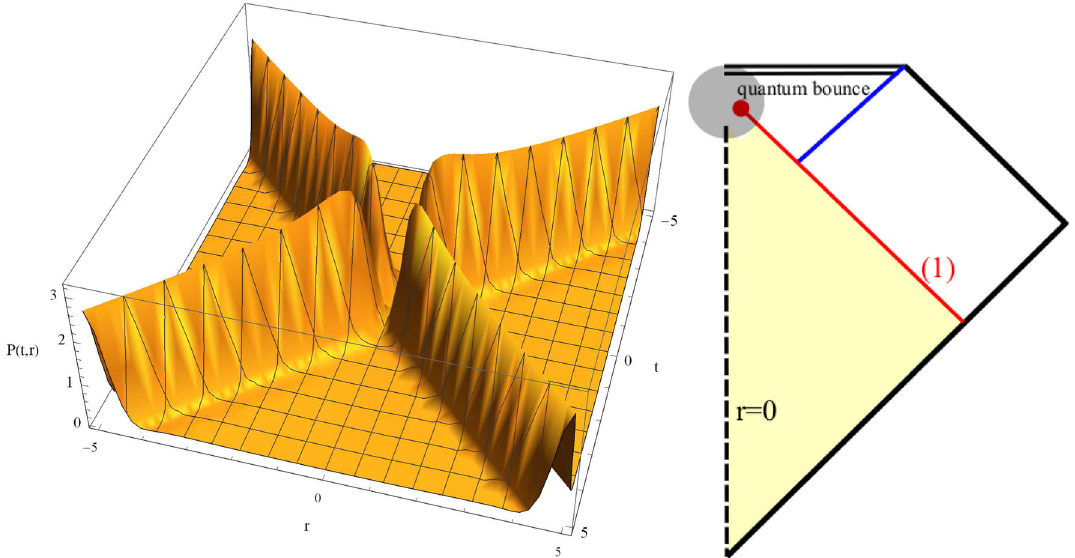
Fig. 4 Left: | (cid:4) (cid:9) | 2 for λ = κ = 1. Right: The physical interpretation of (cid:4) (cid:9)